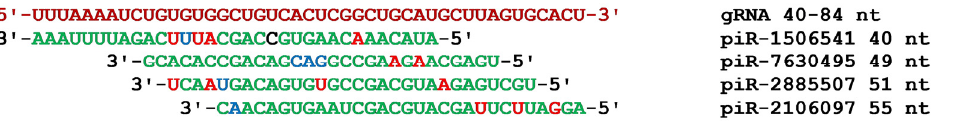
Figure 4. Nucleotide sequences of the piRNA BSs cluster in the CDS of gRNA from 4207 nt to 4241 nt and the nucleotide sequences of four piRNAs. Note: The piRNA nucleotides that form canonical pairs with gRNA are highlighted in green and non ‐ canonical pairs are highlighted in blue. The piRNA nucleotides that do not interact with gRNA are highlighted in red. The names of the piRNAs are followed by the beginning of their BSs. The third cluster of piRNA BSs from 7137 nt to 7161 nt was also located in the nsp3 protein ‐ coding region of gRNA (Figure 5). A feature of this cluster is the presence of a large number of piRNA BSs, all nucleotides of which fully complementary interacted with gRNA. Such a set of piRNAs is guaranteed to provide high human protection against the coronavirus. Only a significant mutation in the cluster of gRNA BSs could increase the protection against the coronavirus of these endogenous piRNAs. Except for piR ‐ 193777, the remaining 13 piRNAs had the same oligonucleotide UUGACAUGUUUGAUGAUG ‐ GAG, which provides strong interaction with gRNA mainly due to canonical base pairs. The first four GGAG nucleotides from the 5 ′‐ end of piRNAs provided strong binding to gRNA through G ‐ C pairs with three hydrogen bonds. The example of this BSs cluster shows that the human genome, in the process of evolution, created protection against SARS ‐ CoV ‐ 2. It seems that it is better for the human genome to maintain a constant set of piRNAs than to frequently adapt to coronavirus mutations, although both ways of pro ‐ tecting against the coronavirus take place. Further research on different strains of SARS ‐ CoV ‐ 2 and other coronaviruses can be conducted to see whether this claim is true.